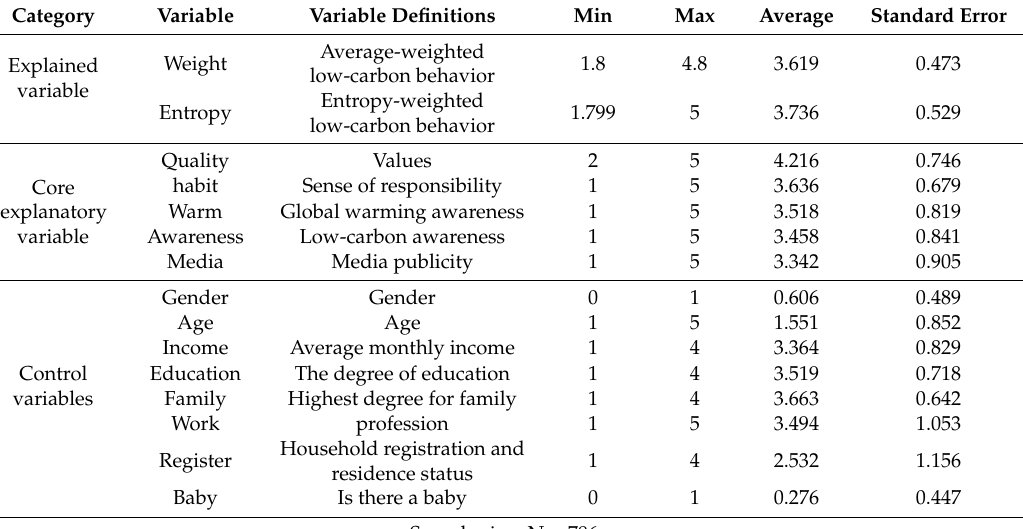
Table 3. Descriptive statistics of